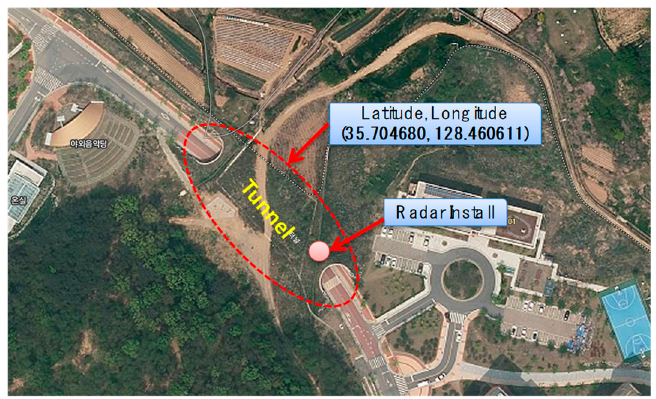
Figure 11. Target tunnel.